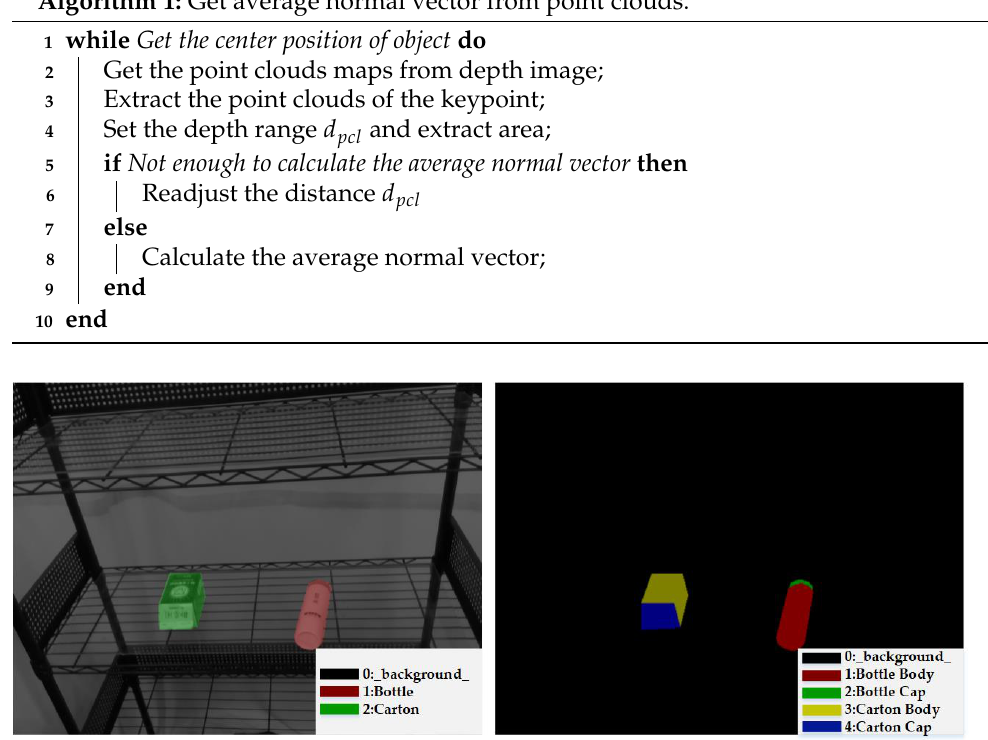
Figure 4. An example of training sample.